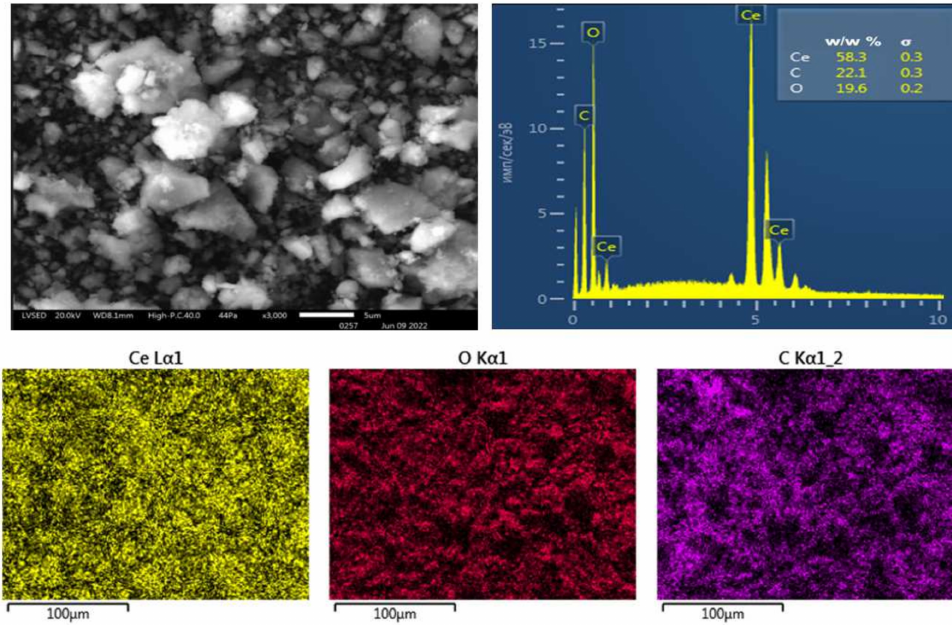
Figure 5. SEM images and EDX spectra of the CeO 2 NPs modified using